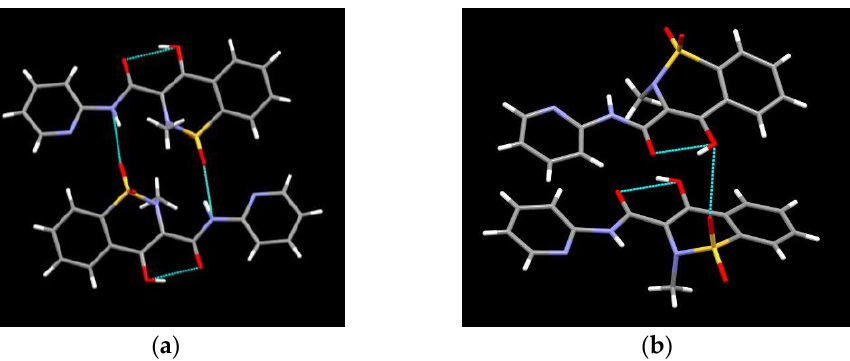
Figure 3. (1.5-column fitting) Illustration of the difference in orientation between the two forms: Piroxicam form I ( a ) (Cambridge Crystallographic Datacenter, reference BIYSEH04) and form II ( b ) (Cambridge Crystallographic Datacenter, reference BIYSEH08). The light blue lines illustrate the hydrogen bonds between the piroxicam molecules in each form, and hydrogen atoms are omitted for clarity.